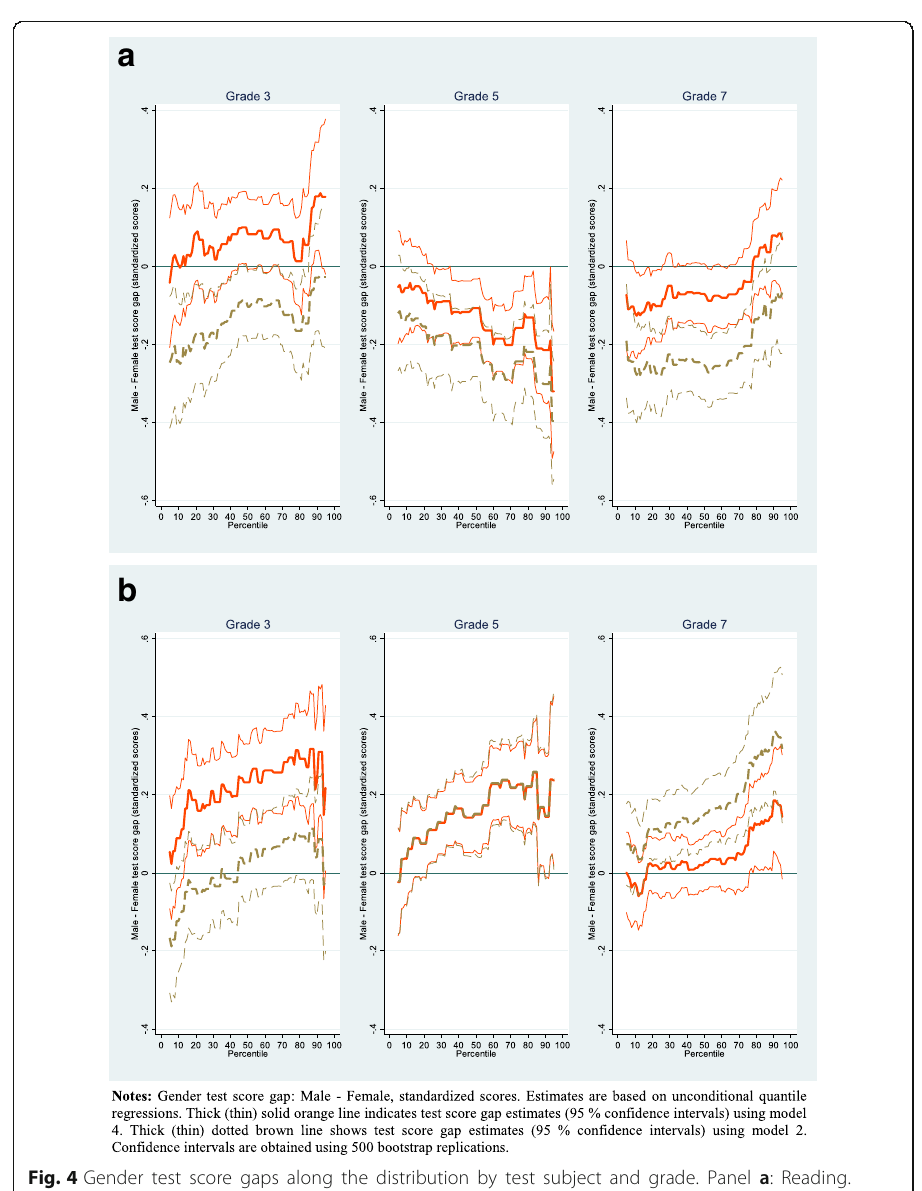
Fig. 4 Gender test score gaps along the distribution by test subject and grade. Panel a : Reading. Panel b :